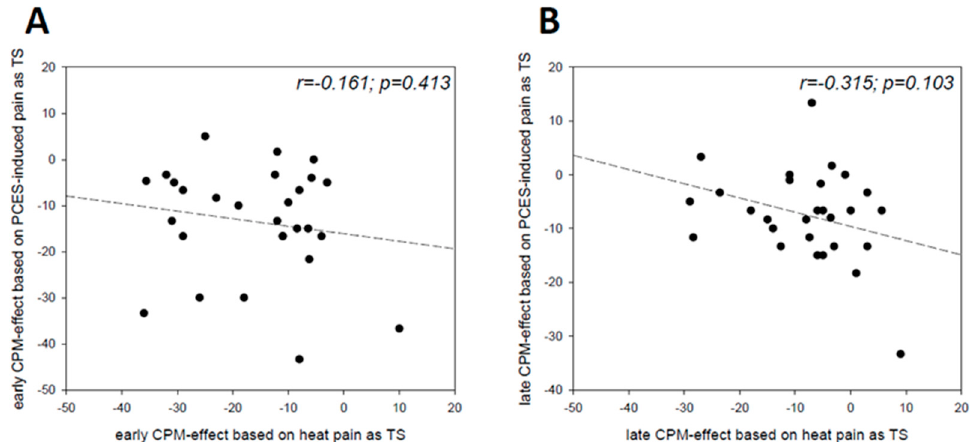
Figure 4. ( A ) Scatter plot of the early CPM-effect based on painful cutaneous electrical stimulation (PCES) as test stimulus (x-axis) and based on heat pain as test stimulus (y-axis). ( B ) Scatter plot of the late CPM-effect based on painful cutaneous electrical stimulation (PCES) as test stimulus (x-axis) and based on heat pain as test stimulus (y-axis).